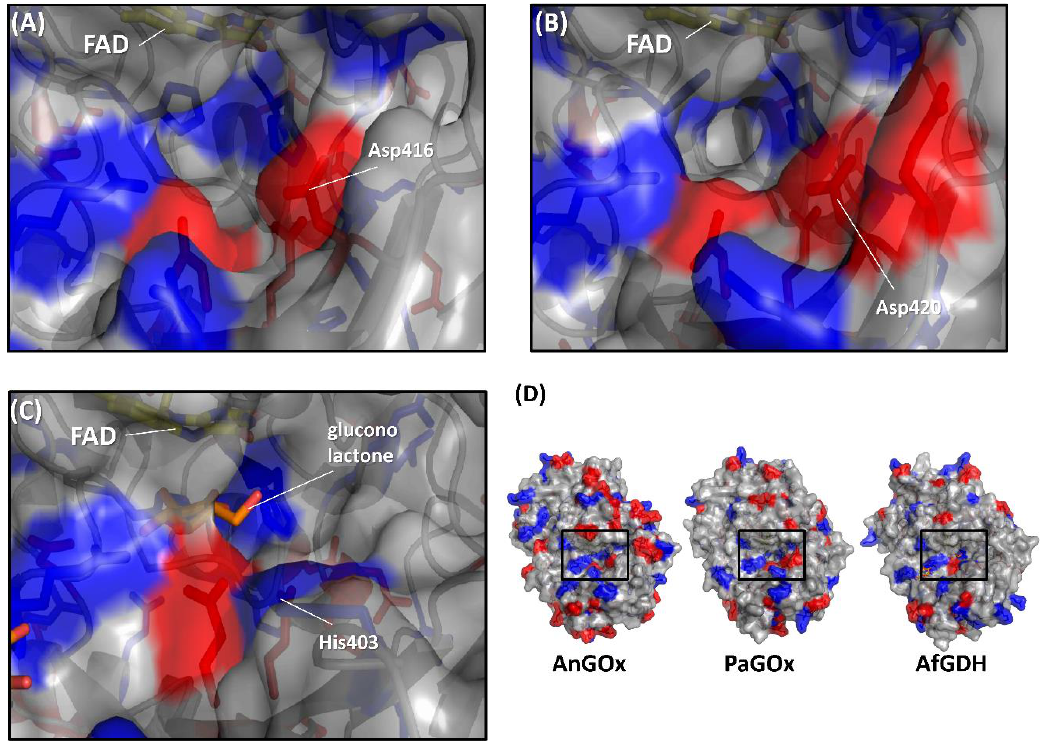
Figure 5. Comparison of the surface charge around the substrate entrance of ( A ) AnGOx (PDB code: 1CF3), ( B ) PaGOx (PDB code: 1GPE), and ( C ) AfGDH (PDB code: 4YNU). ( D ) Whole structure of these enzymes, and black squares show the substrate entrance. The red colored region shows the negatively charged residue, and the blue region shows the positively charged residue. Structure visualization was conducted using the PyMOL Molecular Graphics System, Version 2.2.3 Schrödinger, LLC.